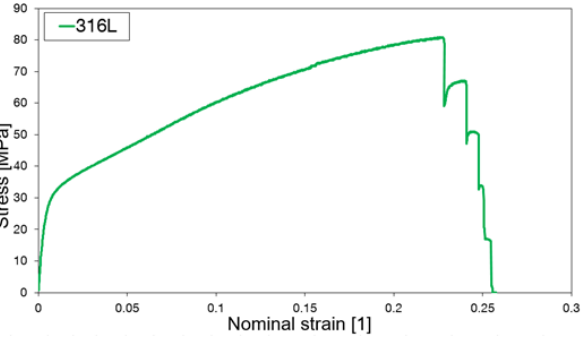
Figure 6. Stress–strain curves for regular honeycomb structure fabricated from stainless steel 316L with visible force peaks corresponding to the failure of individual struts. Curve was obtained in the tensile test.